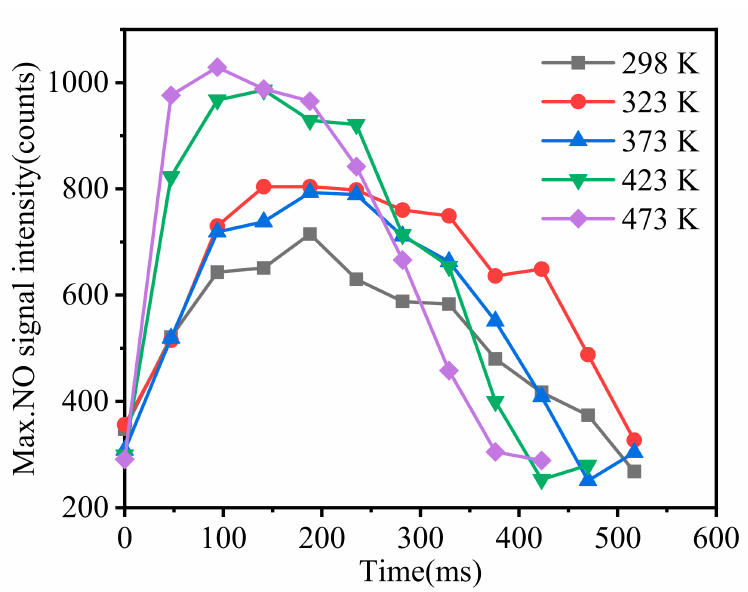
Figure 11. The variation in maximum NO signal intensity with